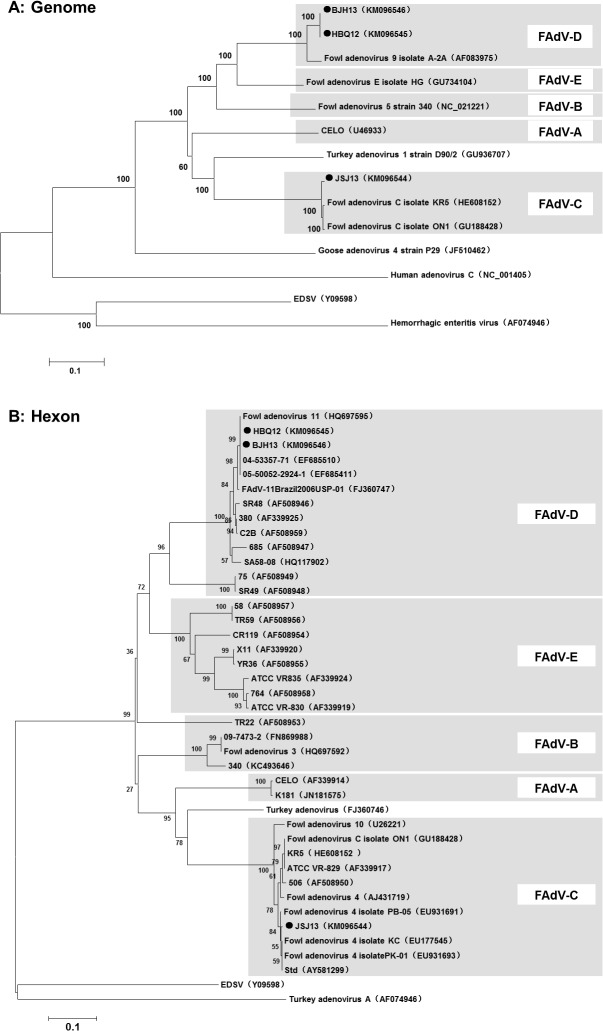
Phylogenetic tree based on the complete genome (A) and hexon gene (B) sequences of avian adenoviruses belonging to genera Aviadenovirus.Strains HBQ12, BJH13 and JSJ13 were sequenced in this study, other avian adenovirus strains were previously sequenced. Phylogenetic tree was generated by the using Neighbor-Joining method in the MEGA4.1 software. Bootstrap values were indicated for the major nodes. Accession numbers of already published adenovirus sequences were given in the brackets.